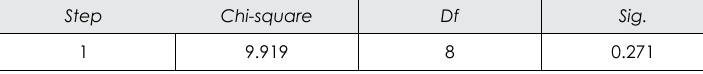
Goodness of fit (Hosmer and Lemeshow test)